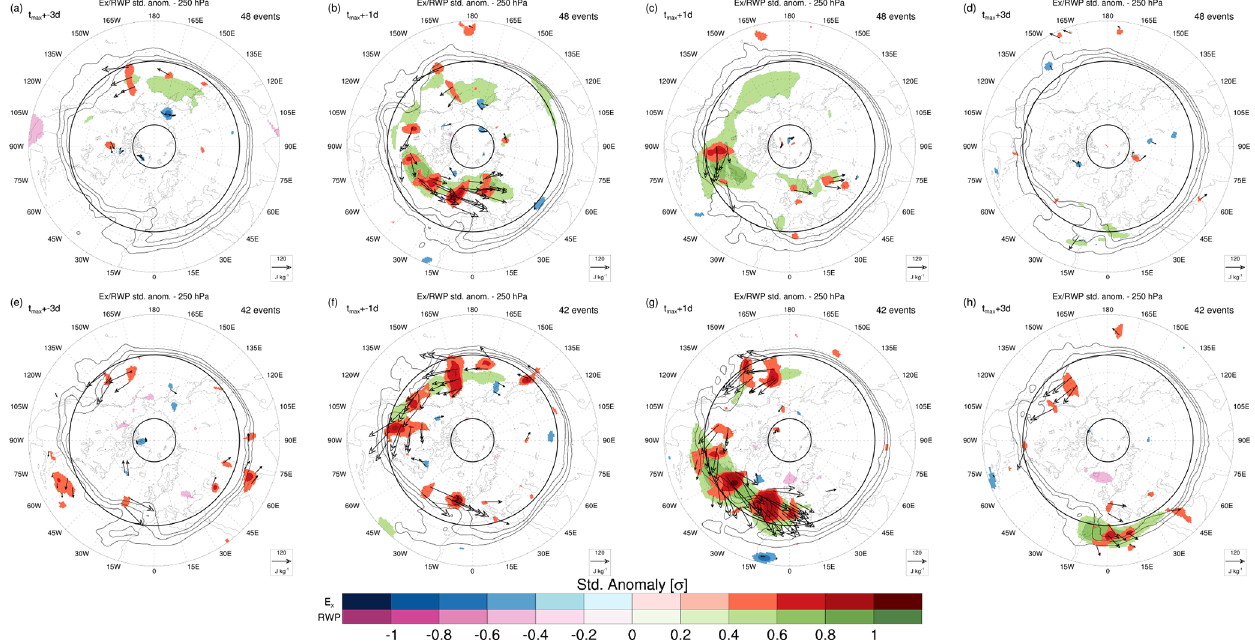
Figure 5. As in Fig. 4 but for lagged composites of daily mean standardized anomalies of E x and RWP amplitude, for high (a–d) PC1 and (e–h) PC2 events, at time lags (a, e) t max − 3d, (b, f) t max − 1d, (c, g) t max + 1d and (d, h) t max +